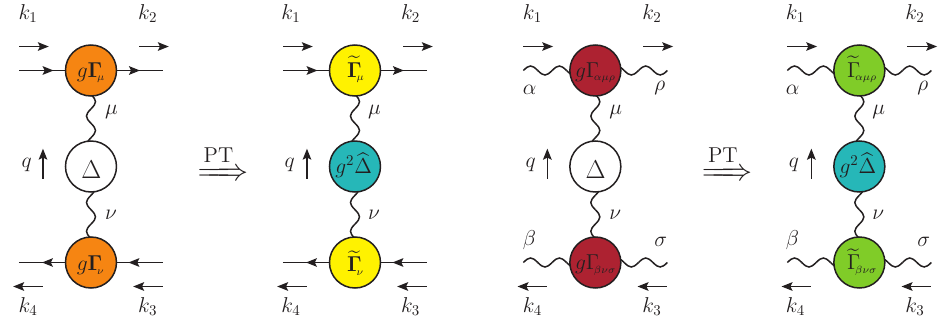
Figure 8. Diagrammatic representation of the basic PT rearrangement in the case of quark–antiquark scattering, corresponding to the S-matrix element of Equation (70) ( left ), and gluon–gluon T q ¯ q → q ¯ q scattering, corresponding to of Equation (71) ( right T gg → gg